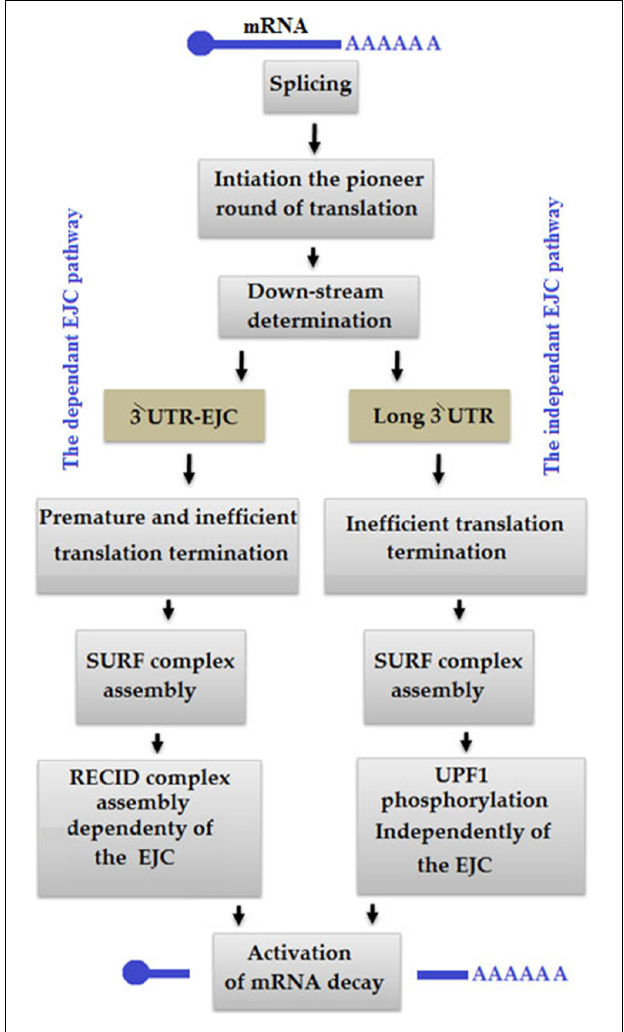
FIGURE 10 | In an exon junction complex (EJC) pathway-dependent nonsense-mediated mRNA decay (NMD) model, the termination of translation occurs at the premature termination codon (PTC) level of ≥ 50–55 nt upstream of EJC, so that the ribosome is unable to dislocate it. In an EJC-independent pathway, PABPC1 distantly occurs from PTC to control eRF1-eRF3, which is related to the termination of translation. promotes SMG1-UPF1 binding to PTC-distal EJC in the DECID complex (Kashima et al., 2006). UPF1 is phosphorylated under the action of SMG1, which later causes mRNA decay and translational repression (Okada-Katsuhata et al., 2012; Durand et al.,